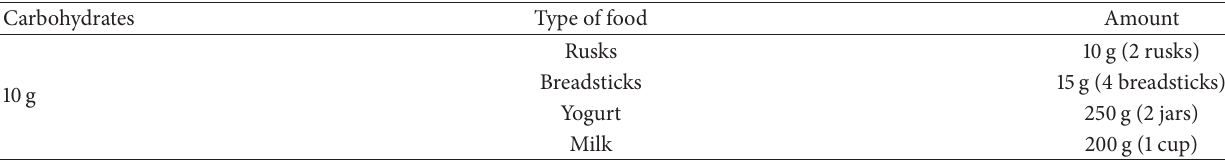
Table 4: Measures to prevent in-hospital hypoglycemic events during subcutaneous insulin treatment, with particular attention to ensuring the recommended intake of carbohydrates in the